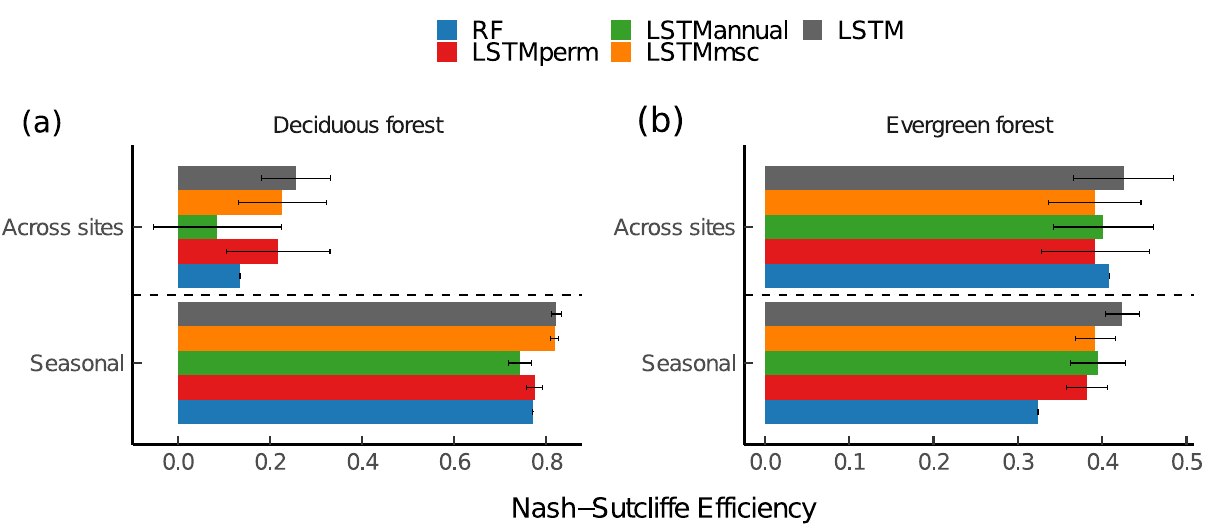
Fig 6. Nash-Sutcliffe modeling efficiency comparison between the proposed LSTM-based models and the other model set-ups for (a) deciduous and (b) evergreen forests. Nash-Sutcliffe modeling efficiency values have been calculated based on the mean ensemble ± sd of the 50 model runs. LSTM = LSTM model using the full depth of the Landsat time series and climate data; LSTM perm = LSTM model but the temporal patterns of both the predictive and the target variables were randomly permuted while instantaneous relationships between predictive and target variables were kept; LSTM msc = LSTM model but the Landsat time series for each band were replaced by their mean seasonal cycle, while using the actual values of air temperature (T air ), precipitation (P), global radiation (Rg), and vapor pressure deficit (VPD); LSTM annual = LSTM model but the Landsat time series for each band were replaced by their annual mean, while using the actual values of T , P, Rg, and VPD, RF = Random Forest model using the actual values of the air Landsat time series and climate